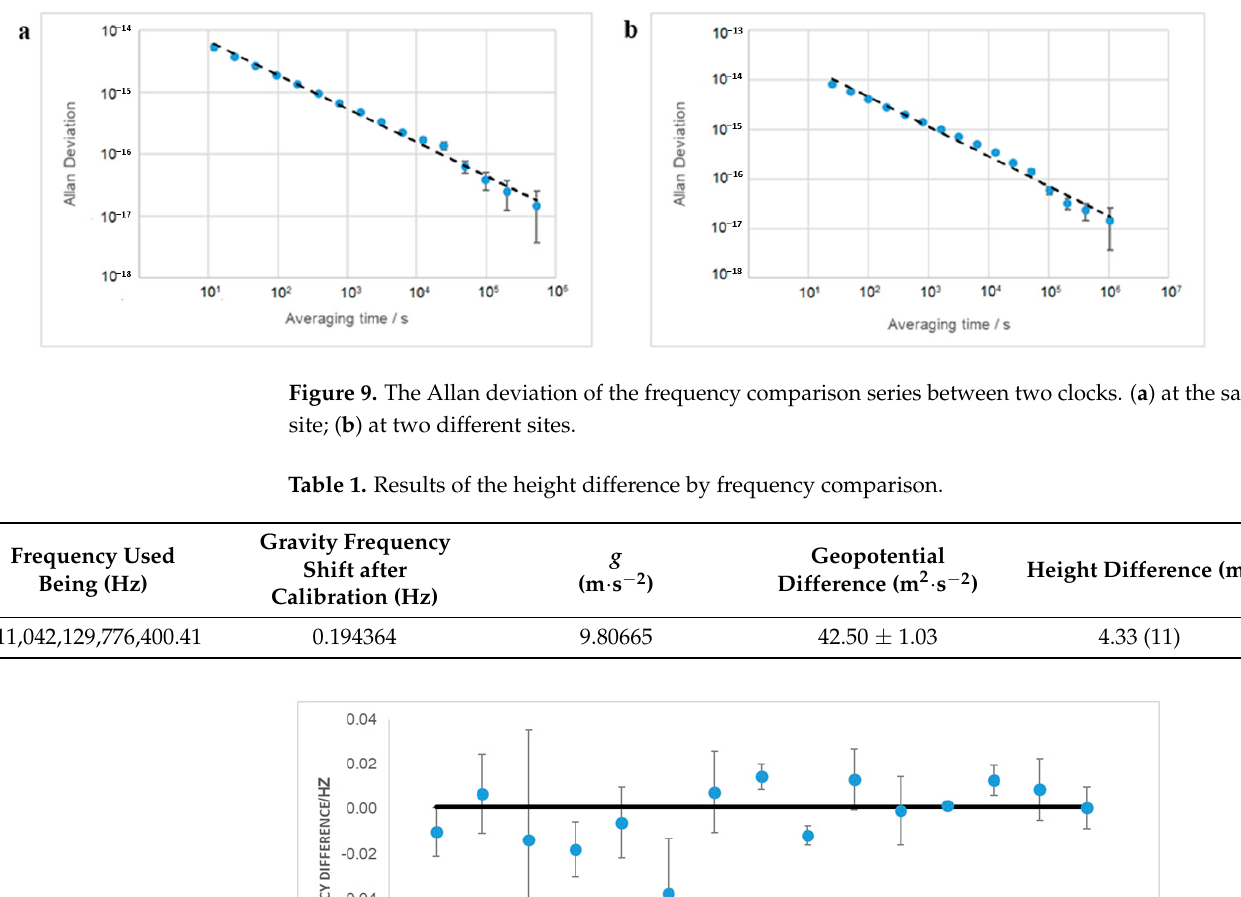
Table 1. Results of the height difference by frequency comparison.